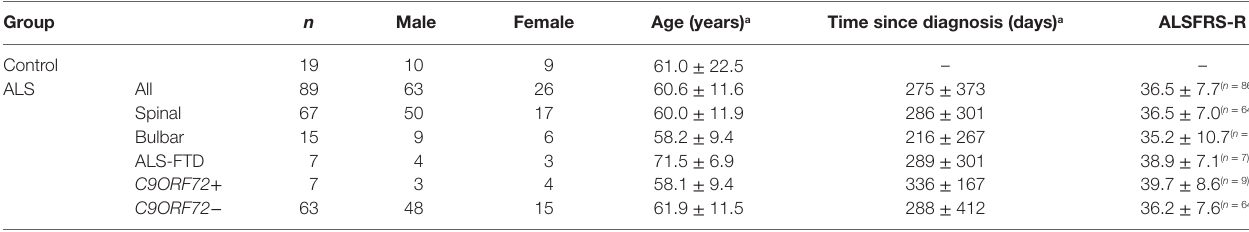
Table 1 | Age, gender, and diagnosis status of the participants. group